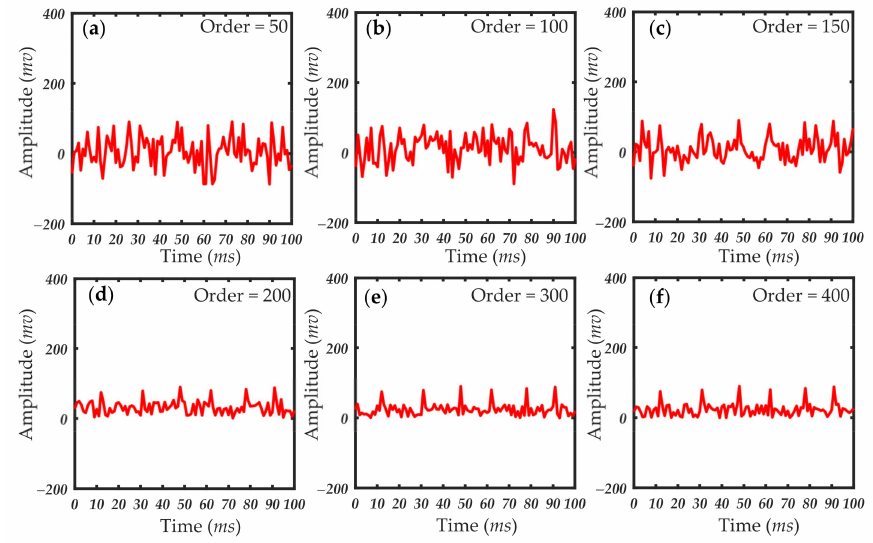
Figure 12. Results of 0.2 µ m particles under different filter order settings: ( a ) filter order = 50; ( b ) filter order = 100; ( c ) filter order = 150; ( d ) filter order = 200; ( e ) filter order = 300; ( f ) filter order =